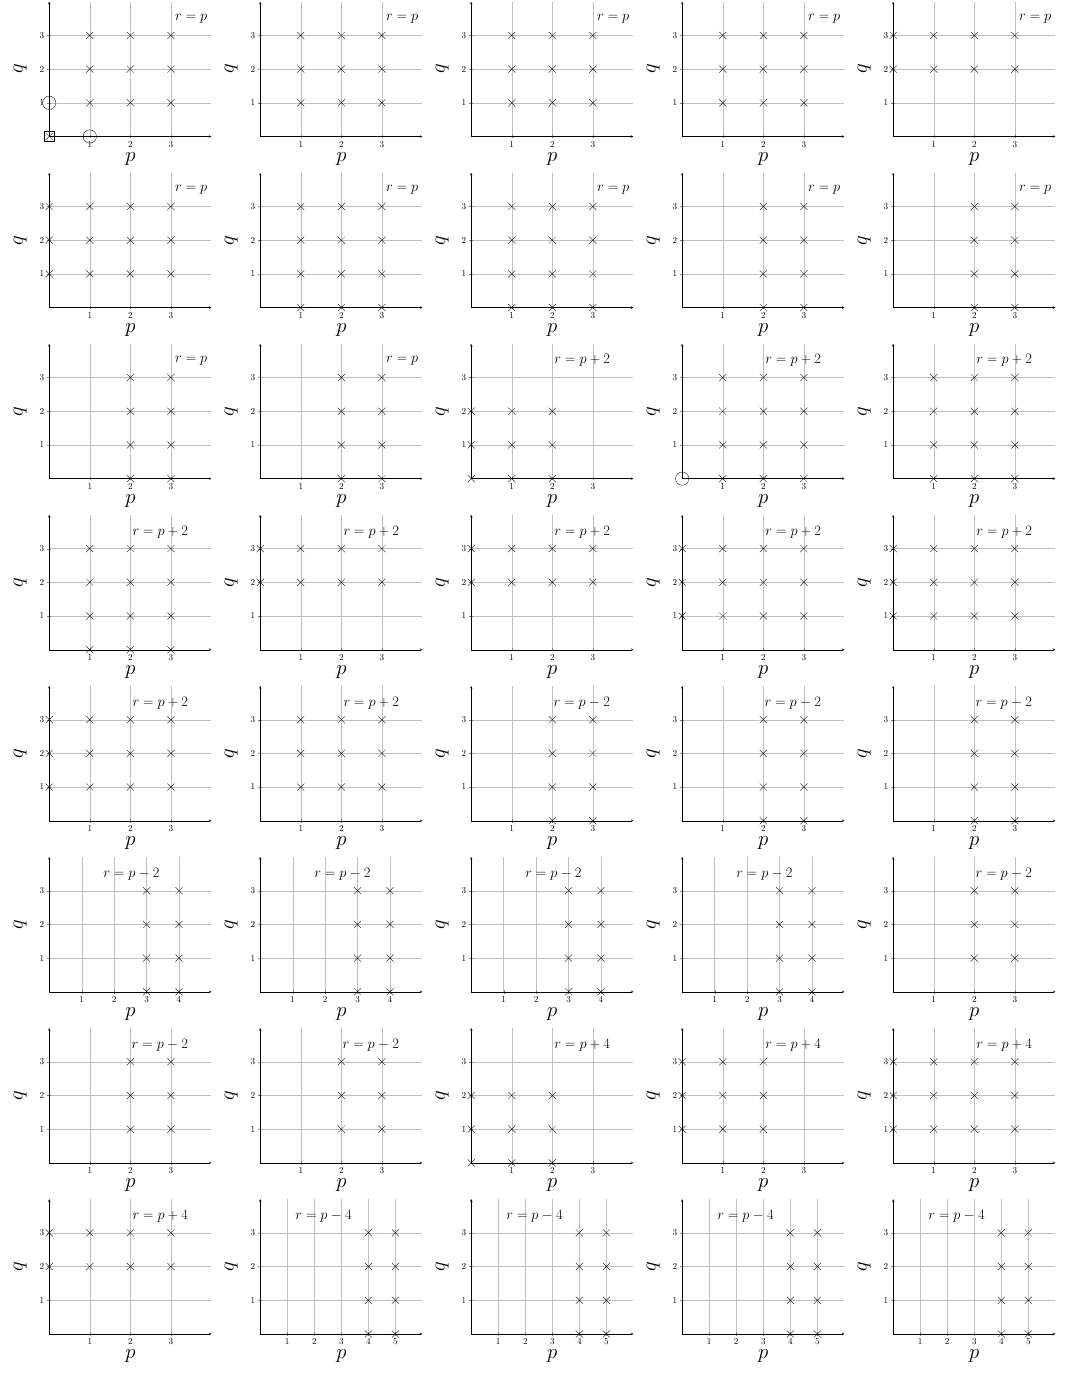
Figure 10. /D 3 towers. The empty circles mark modes which appear from the decomposition of / 2 representations of SO(8) on the round sphere, but do not exist when derived in the conventional method. The excess modes are (1 , 0; 1) = ( 4 , 2 ), (0 , 1; 0) = ( 5 , 1 ) and (0 , 0; 2) = ( 1 , 3 ). The square with a cross, on the other hand, emphasises the fact that the G irrep (0 , 0; 0) = ( 1 , 1 ) appears in the squashed spectrum but is not produced in the spontaneous symmetry breaking of the round sphere